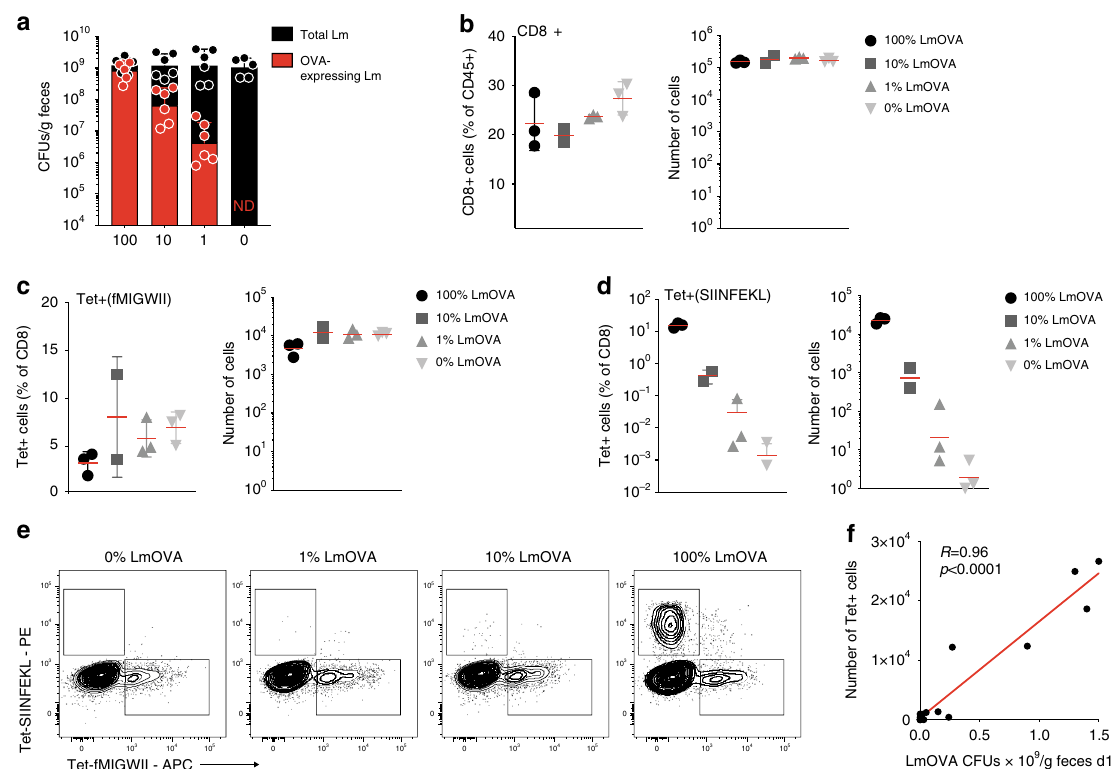
Fig. 5 High antigen load favors expansion of antigen-speci fi c intestinal CD8 + T cells. a C57Bl/6 mice were administered streptomycin and one day later infected with a total of 10 7 Lm CFUs, containing the depicted varying percentages of LmOVA, and a remainder fraction of WT Lm (not expressing OVA). Bars show mean CFUs enumerated for the two Lm strains (WT Lm and LmOVA) in fecal pellets at day 1 post inoculum, obtained through selective plating ( n = 5-6, from 2 independent experiments; shown are means ± SD). b , c Percentage and absolute numbers for total CD8 + T cells and H2-M3:fMIGWII- speci fi c CD8 + T cells in the LILP of mice treated as described in a , at day 9 post infection ( n = 2 – 3 per group). d , e Representative FACS plots and quanti fi cation of H2-Kb:SIINFEKL-speci fi c CD8 + T cells in the LILP of animals treated as shown in a at day 9 post infection ( b – e : n = 2 – 3, one representative of 2 experiments shown; shown are means ± SD for percentages and geometric means for absolute numbers). f Pearson correlation between number of SIINFEKL-speci fi c T cells in the LILP at day 9 p.i. and LmOVA CFUs/g of feces at day 1 post inoculum in mice treated as described in a (r correlation coef fi cient, and two-tailed are shown in fi gure). Shown in red is the linear regression curve ( n = 19 data points from 2 independent